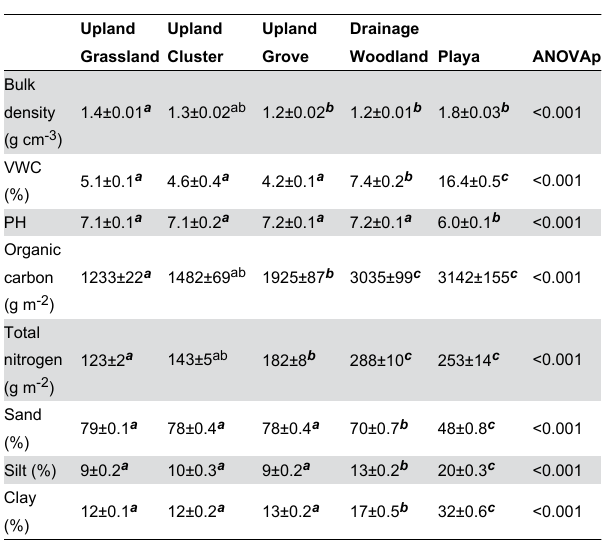
Table 1. Mean (+ standard error) values of soil (0-15 cm depth) variables and ANOVA results along a catena gradient in a subtropical grassland undergoing woody plant encroachment.